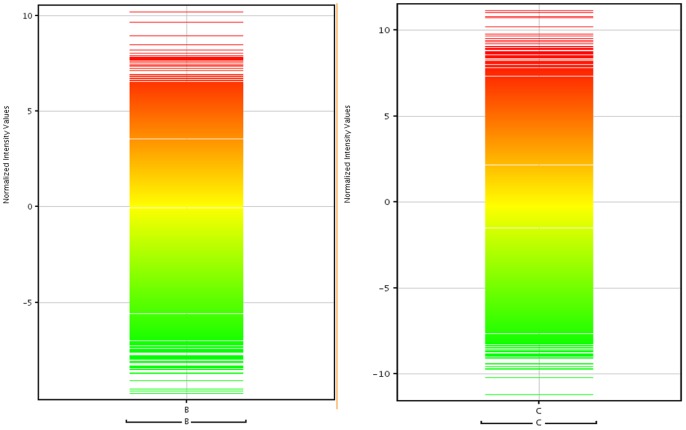
Expression profile of the differentially expressed transcripts (A) in cultivar B with respect to A (B) in cultivar C with respect to A.